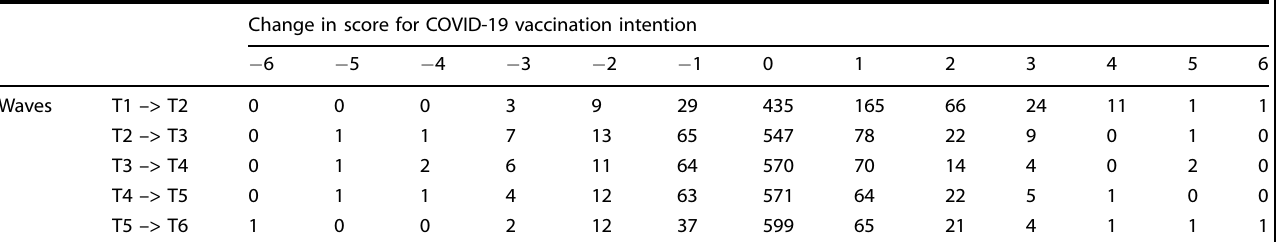
Table 1. Number of respondents that changed their score on the 7-point Likert answer scale for COVID-19 vaccination intention for each wave. Change in score for COVID-19 vaccination